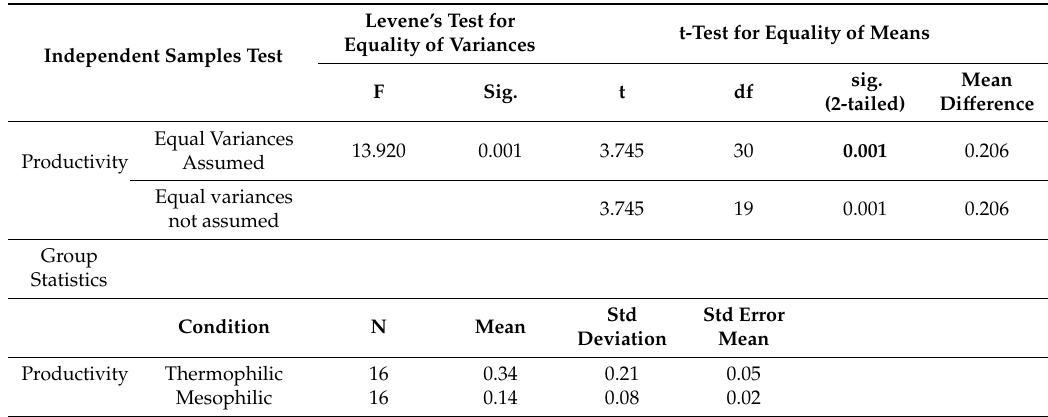
Table 3. Summary of t-test for the measured biogas production between mesophilic and thermophilic